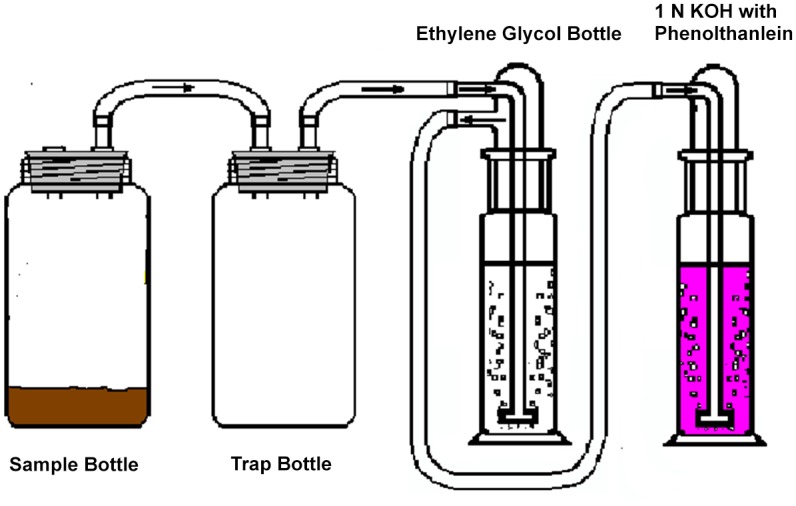
Experimental set-up for the study of metsulfuron-methyl degradation in soil.